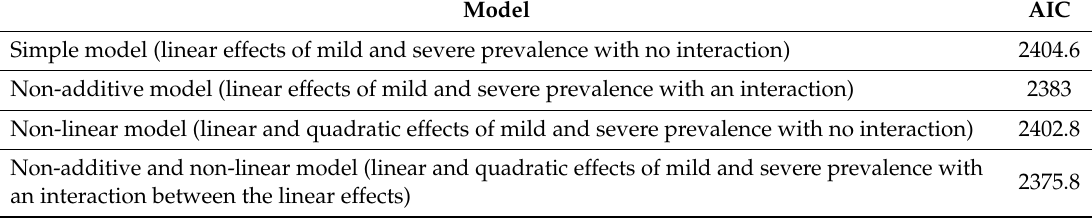
Table 1. Comparison of model fit on Akaike’s Information Criterion (AIC) for four models describing the relationship between lameness prevalence and the acceptability of the scenario according to expert opinion. Smaller AIC scores indicate a better-fitting model.